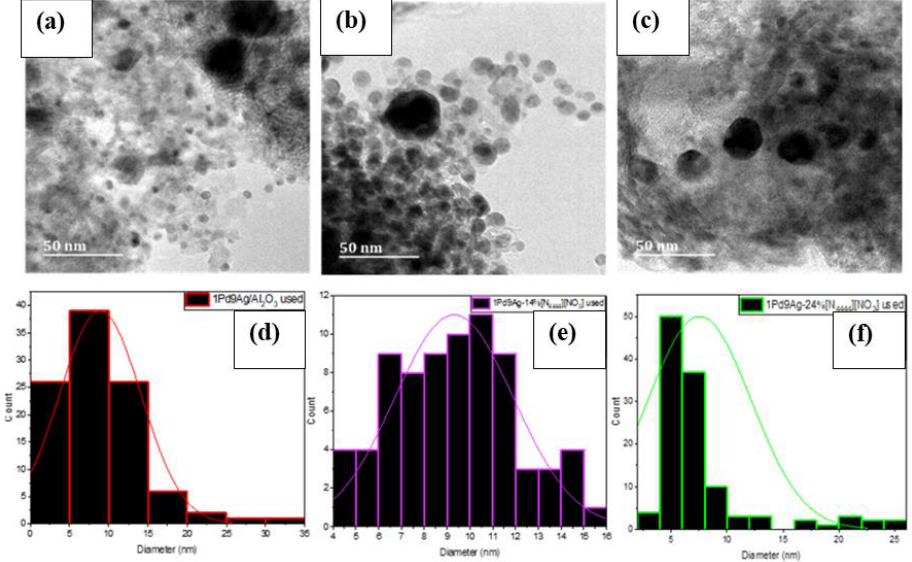
Figure 8. STEM-EDX images of used ( a ) 1Pd9Ag/Al 2 O 3 , ( b ) 1Pd9Ag-14%[N 4444 ][NO 3 ], and ( c ) 1Pd9Ag-24%[N 4444 ][NO 3 ] catalysts with their respective particle size distribution graphs ( d – f ).